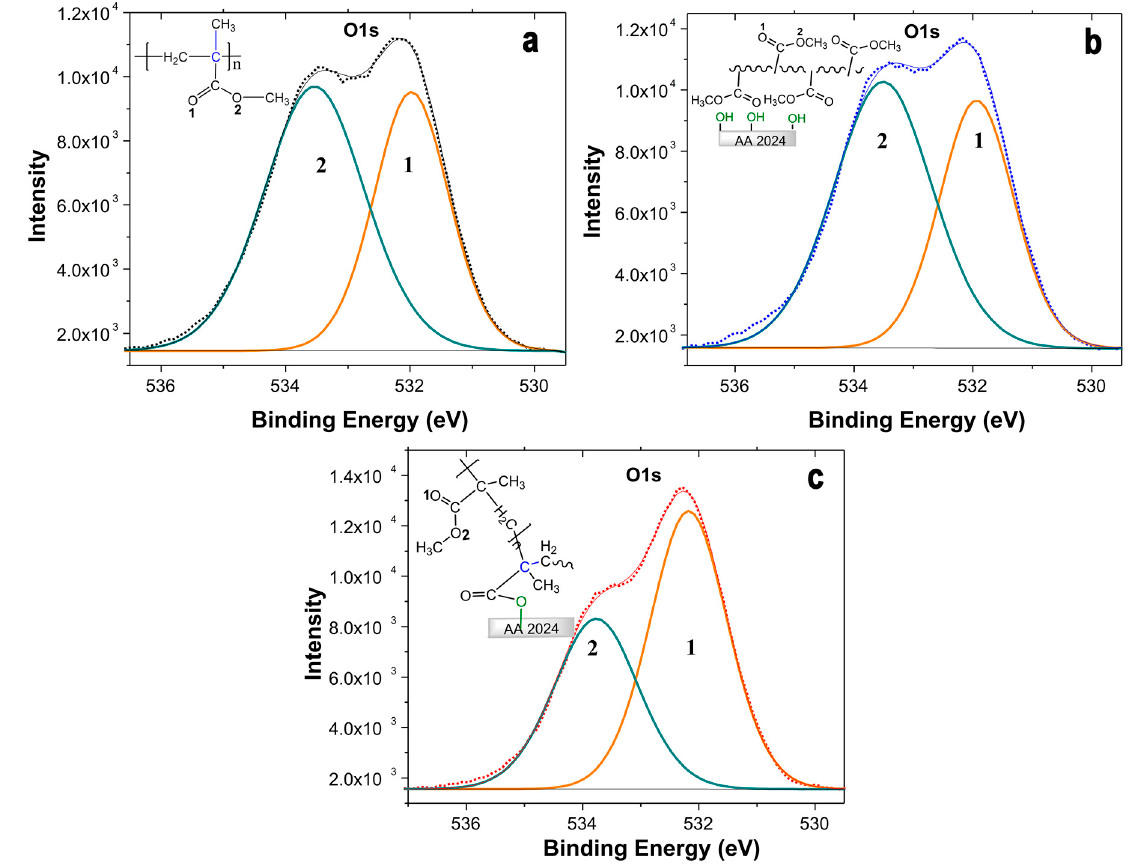
Figure 5. XPS spectra showing the O1s peaks of: ( a ) Poly(methyl methacrylate), ( b ) aluminum alloy coated with poly(methyl methacrylate) (AA-PMMA), and ( c ) aluminum alloy modified with pseudotransesterification and then polymerized with methyl methacrylate (AA-TE-PMMA).